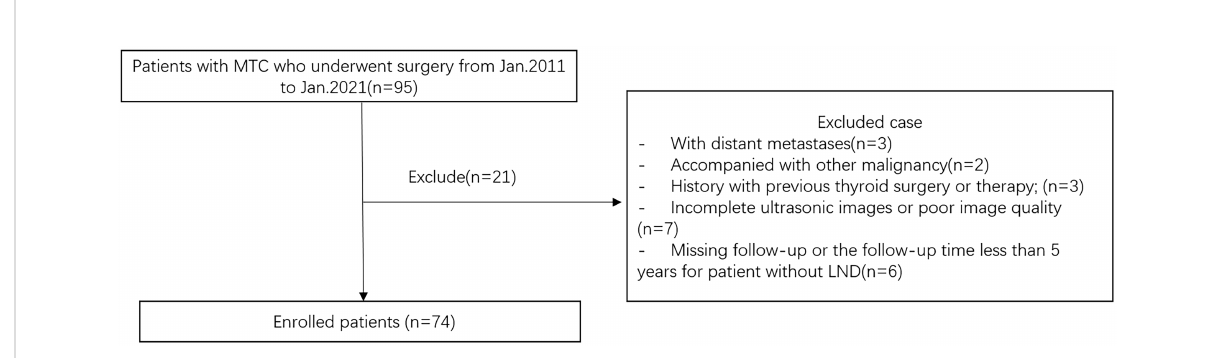
FIGURE 1 Flowchart of the patients enrolled in our study. MTC, medullary thyroid carcinoma; LND, lymph node